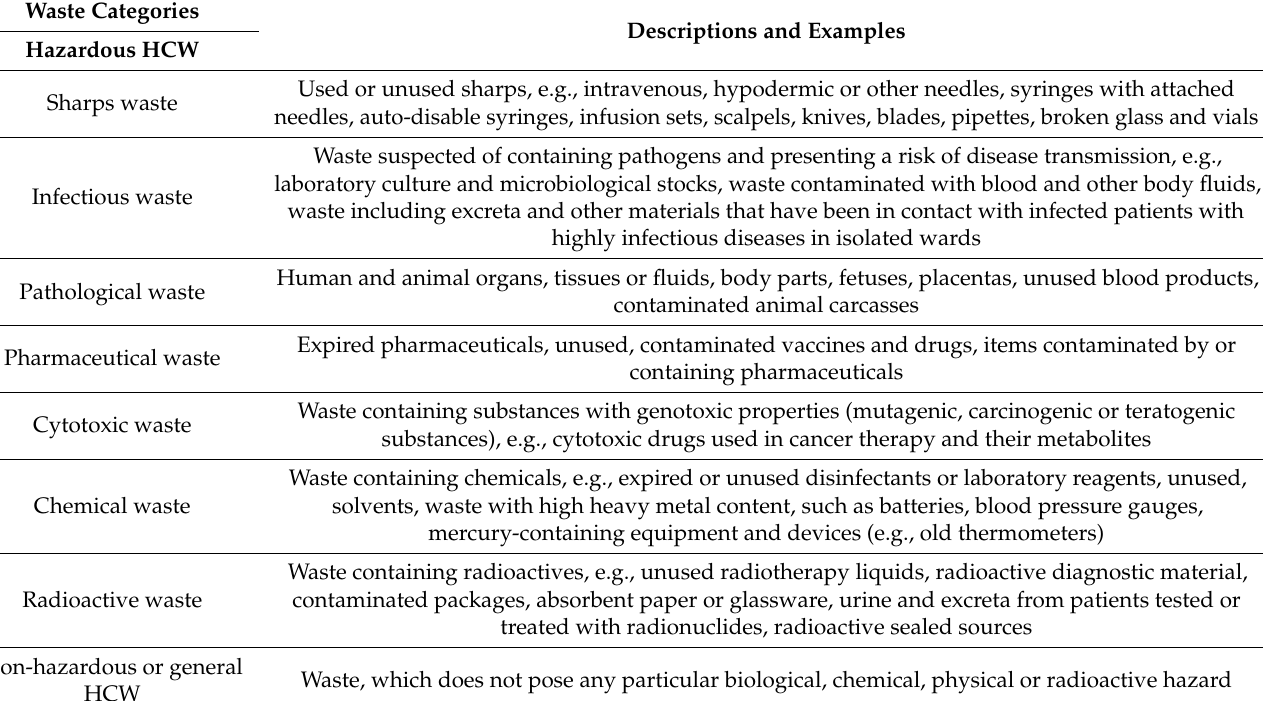
Table 1. Categories of healthcare waste.